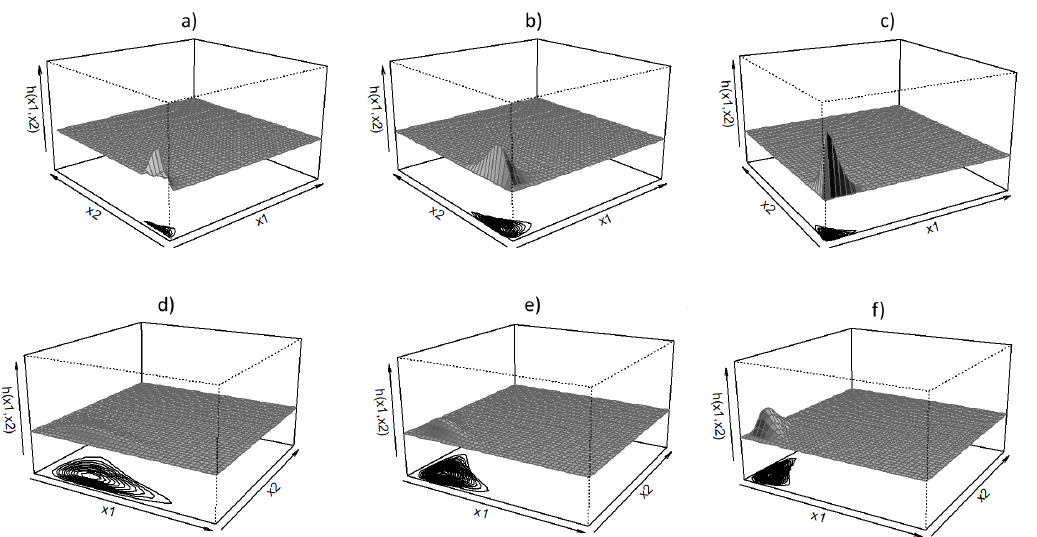
Figure 3. Example pdfs and contour plots of ( 10 ) for various values of ( α 1 , α 2 , α 3 , δ 1 , θ 1 , δ 2 , θ 2 , λ ) when ( a )